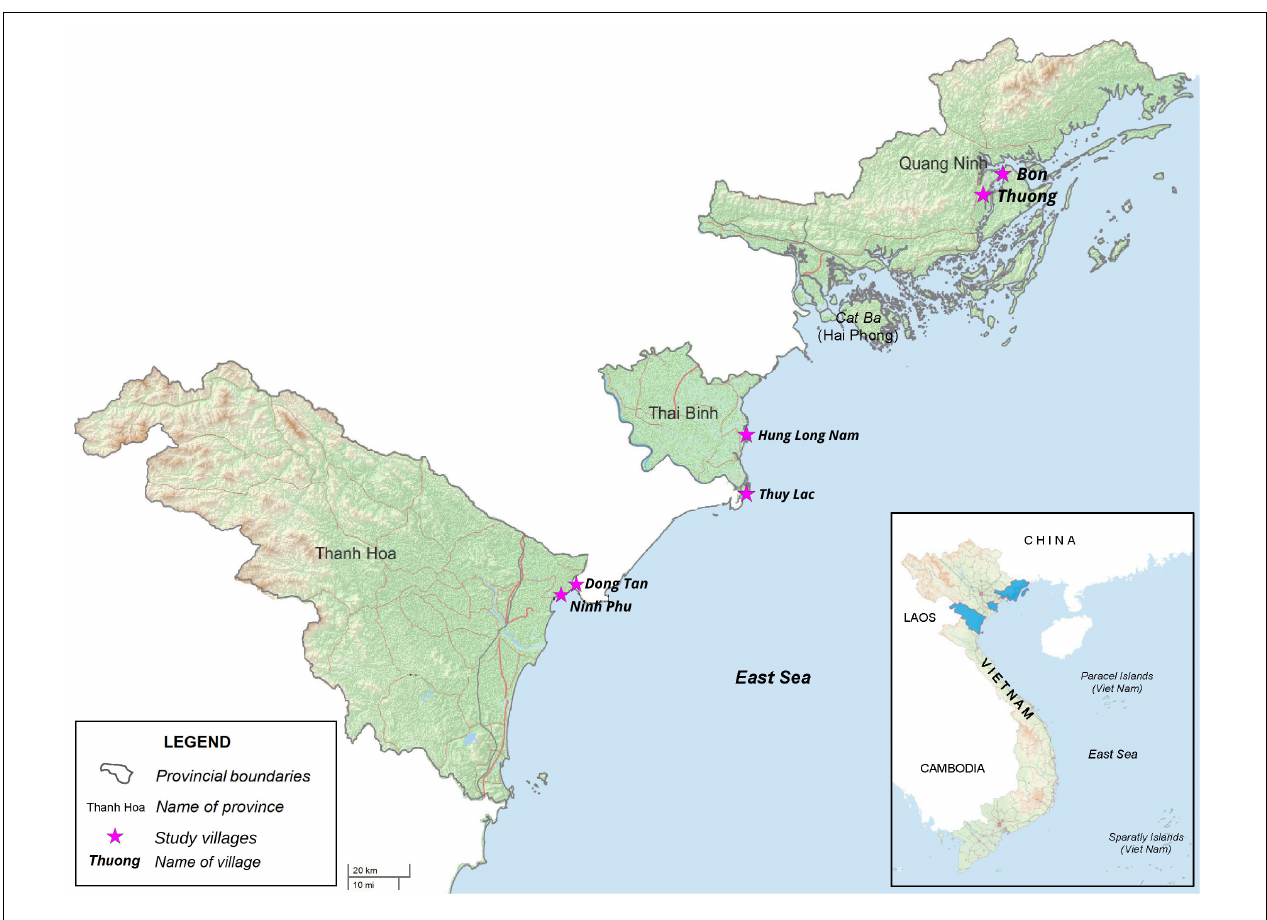
FIGURE 1 | Study location